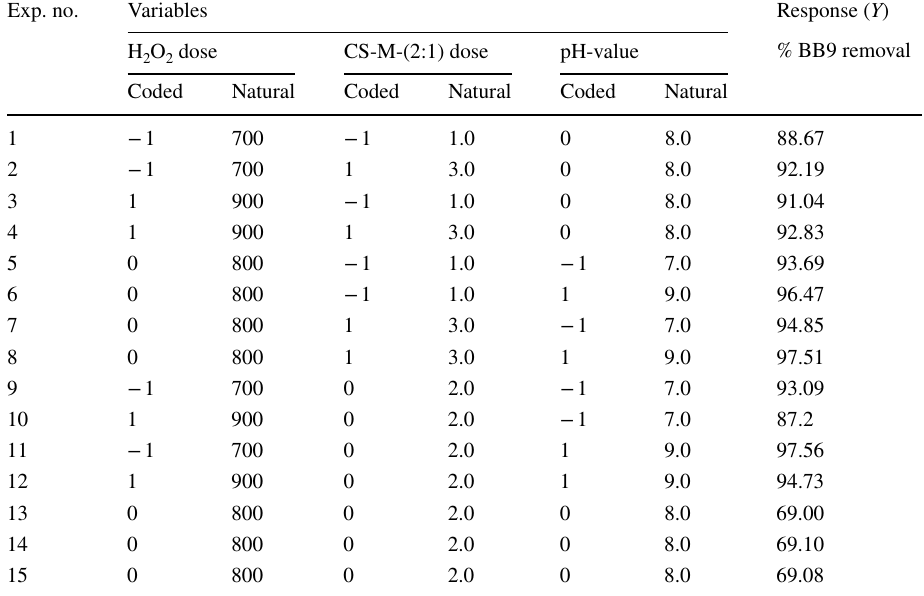
factorial design in coded and natural of experiments and the corresponding to the carbamate removal response influencing wastewater oxidation by modified Fenton-lime system